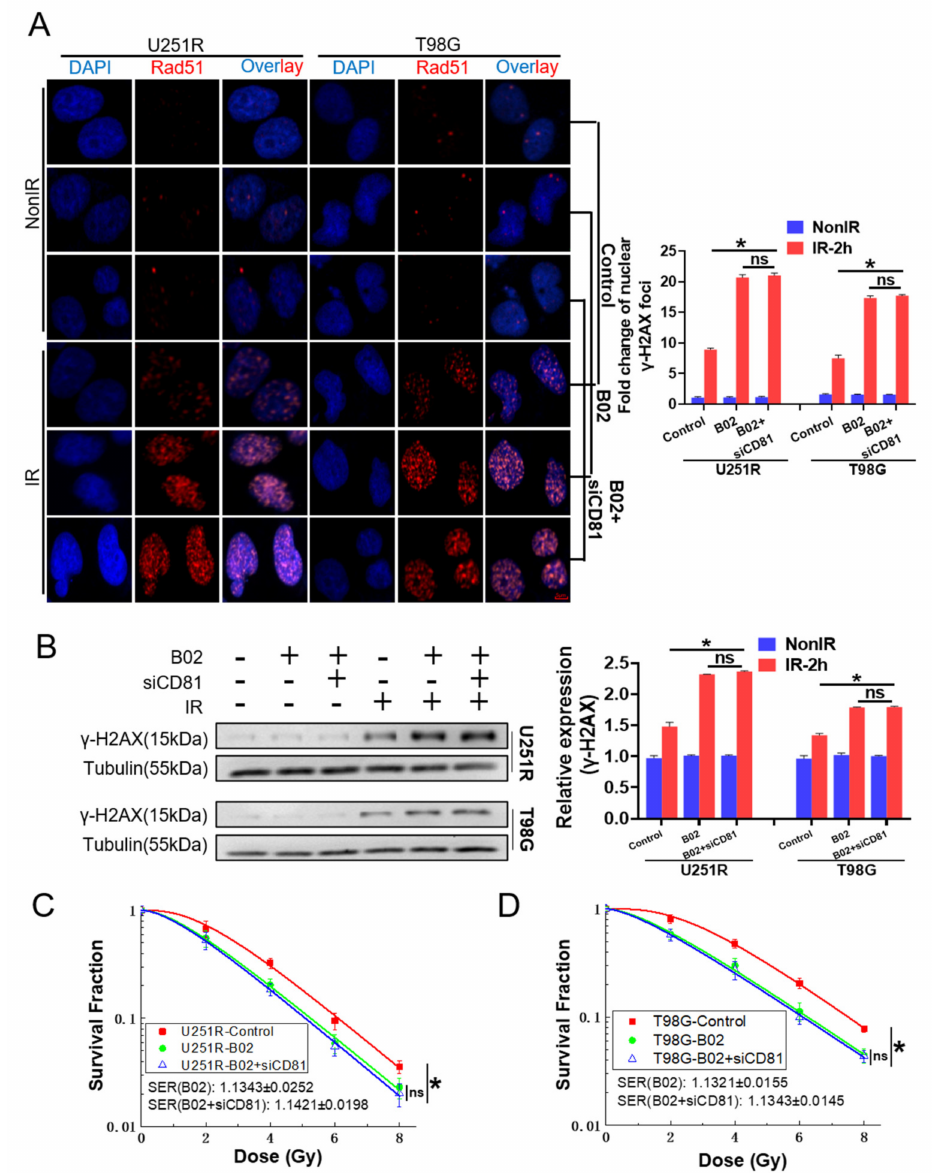
Figure 6. Rad51 was indispensable for CD81-regulated radioresistance. U251R and T98G Cells were treated with B02 (10 µ M), its control (1‰ DMSO), or B02 + siCD81 and then irradiated with X-rays. ( A ) Representative immunostaining images ( left ) and quantification ( right ) of γ -H2AX foci in the cells at 2 h after 6 Gy irradiation. Blue, DAPI stained nuclear. Red, γ -H2AX foci. ( B ) Western blot assay ( left ) and quantitation ( right ) of γ -H2AX level at 2 h after 6 Gy irradiation. ( C , D ) Clonogenic survivals of X-ray irradiated U251R ( C ) and T98G ( D ) cells under different treatment of B02 or B02 + siCD81. *, p < 0.05 between indicated groups. ns, no significant difference ( p > 0.05 between indicated